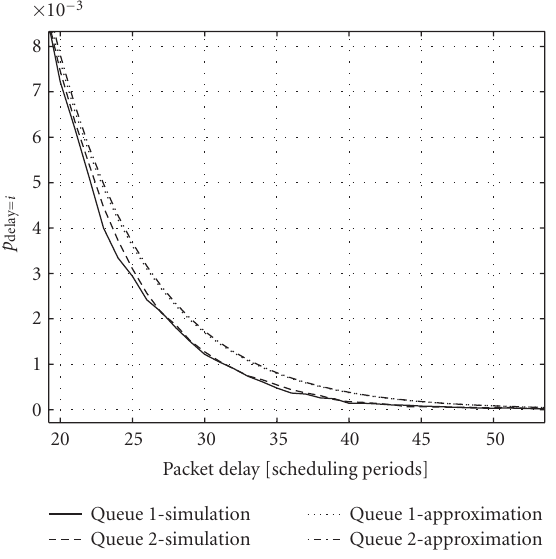
Figure 6: Distribution of the packet delay (detail).